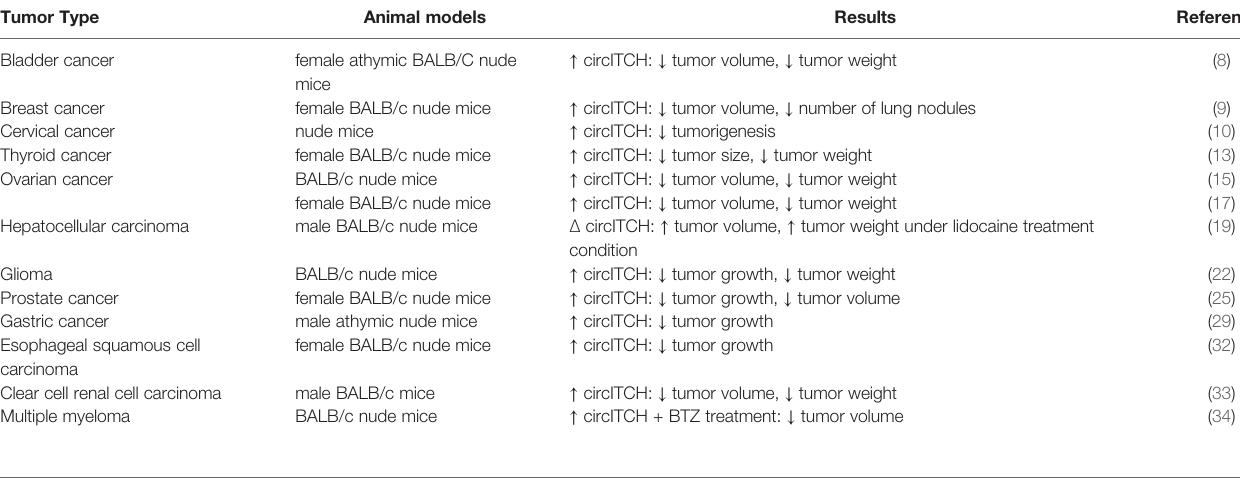
TABLE 2 | Summary of studies which assessed impact of circITCH up-regulation or silencing in animal models ( Δ : knock-down or deletion, BTZ: Bortezomib). Tumor Type Animal models